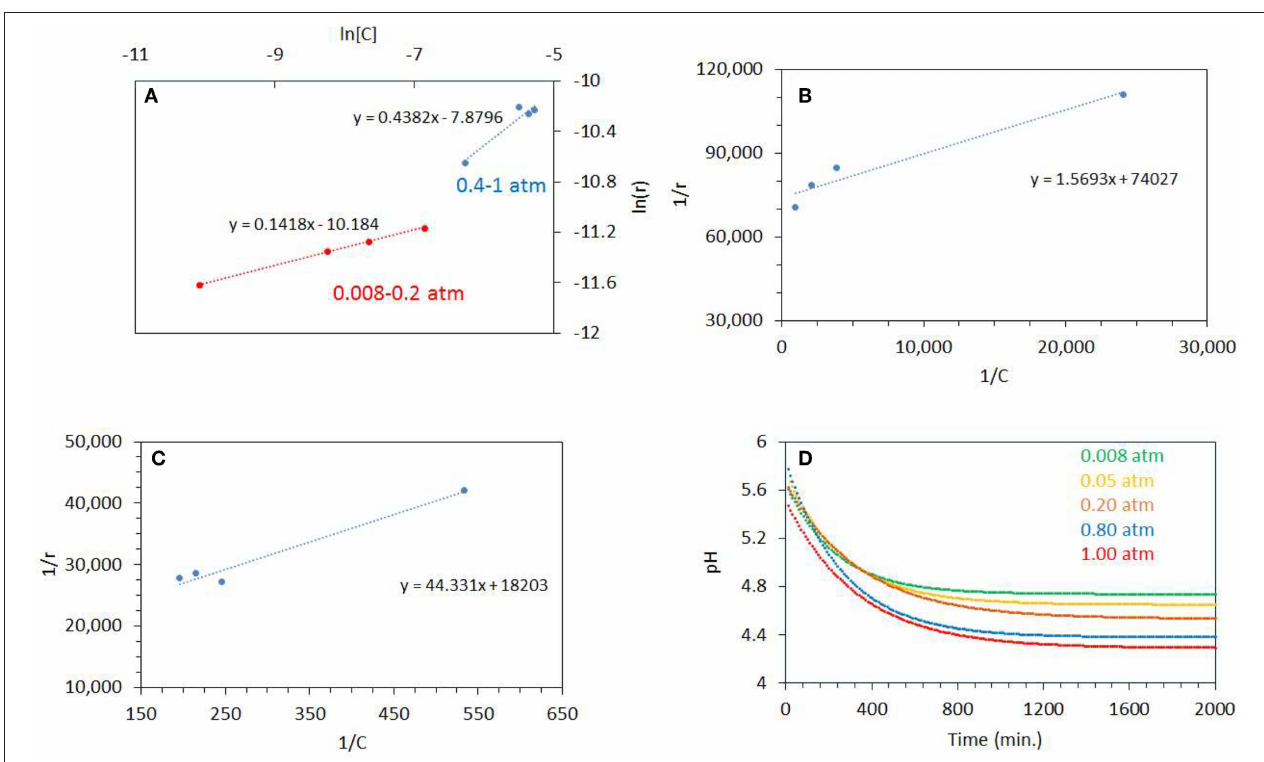
FIGURE 7 | (A) ln[ C ] vs. ln( r ) where C is the concentration of dissolved oxygen and r is the rate of ethylene glycol disappearance. The photoreactions were performed from 0.08 to 0.20 atm P O2 and 0.4 to 1 atm P O2 . (B) 1/r (g catal .min/mol) vs. 1/ C (g Catal. /mol), where C is the concentration of dissolved oxygen and r is the rate of ethylene glycol disappearance. The photoreactions were performed from 0.08 to 0.20 atm P O2 . (C) 1/r (g catal .min/mol) vs. 1/ C (g Catal. /mol), where C is the concentration of dissolved oxygen and r is the rate of ethylene glycol disappearance. (D) Decrease in pH during the Photoreaction at 0.08–1 atm initial P O2 . The line is fitted by exponential decay equation. The ethylene glycol concentration was 0.5 vol.% (0.067M) and 5mg of catalyst was used for the